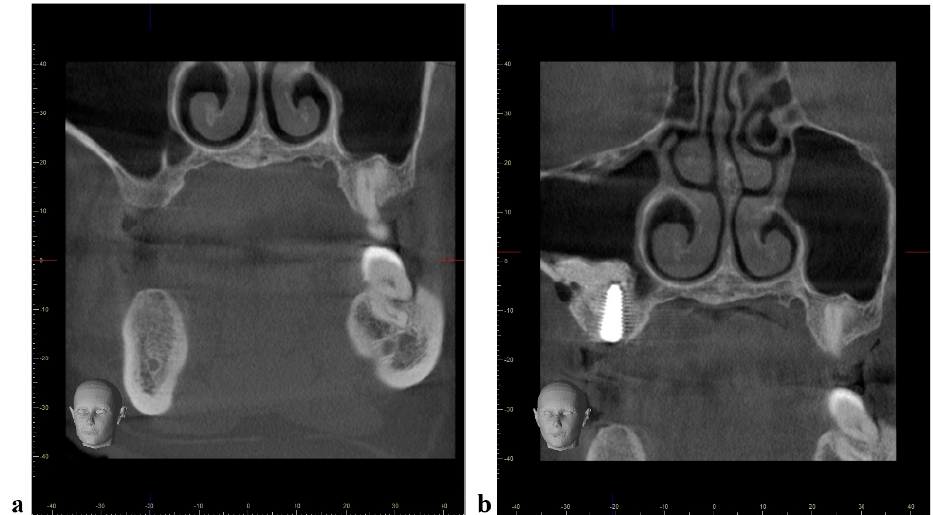
Figure 4. Management of antero-posterior septa. ( a ) CBCT coronal view of the left maxilla with a antero-posterior oriented septa. ( b ) CBCT coronal view after maxillary sinus floor augmentation with simultaneous dental implant placement (one window from lateral approach)—the implant prosthetically driven position did not require augmentation of the medial compartment of the sinus.